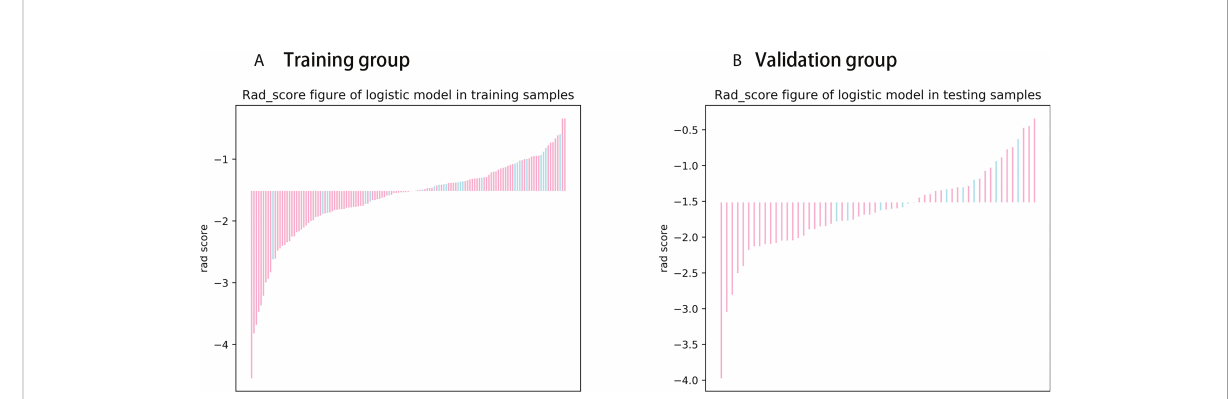
FIGURE 4 Rad score chart for training and validation groups. (A, B) show the distribution of radiomics scores for the training and validation groups respectively. The pink bars represent the radiomics scores of patients who did not experience disease progression, while the blue bars represent the radiomics scores of patients who experienced disease